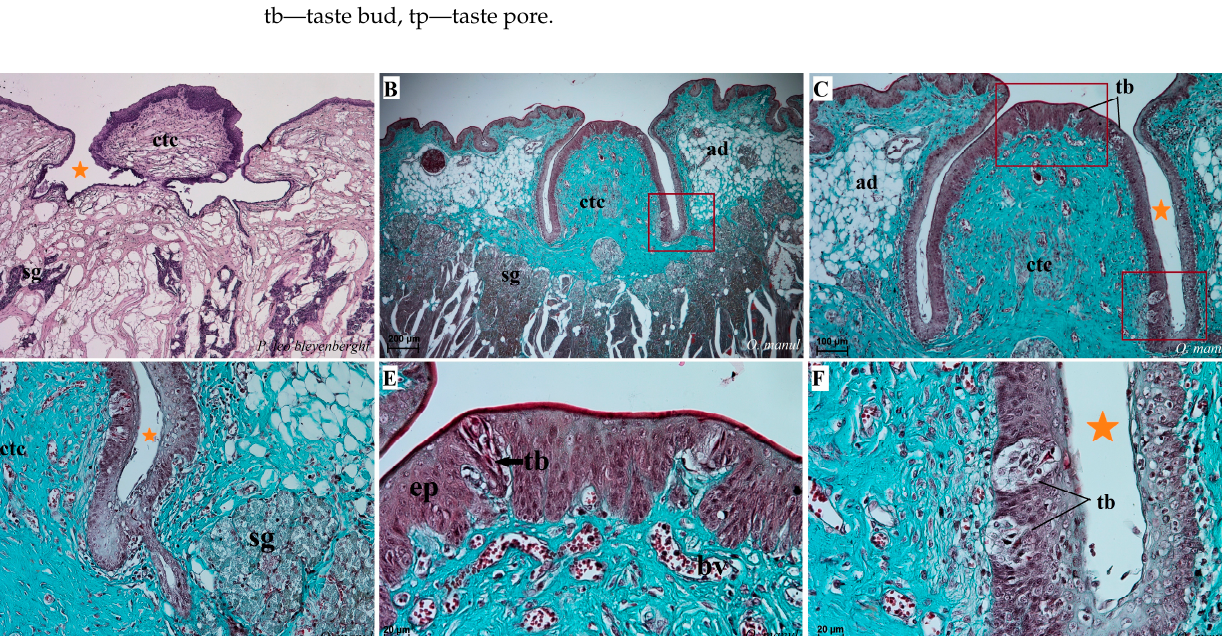
Figure 10. Histological pictures of the vallate papillae of the tongue of P. leo bleyenberghi ( A ) and O.